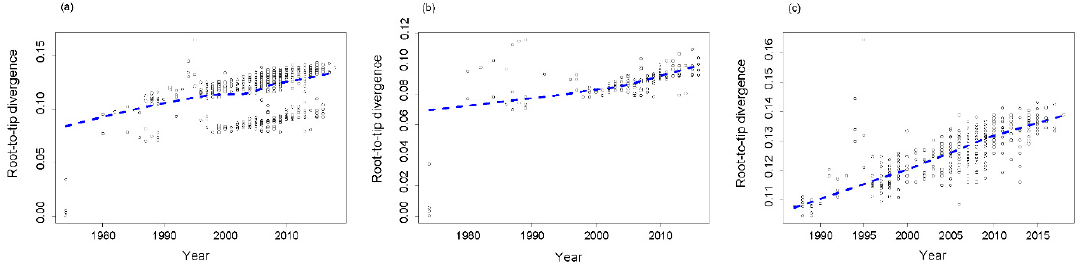
Figure 4. Root-to-tip divergence plots of the RVA G1 VP7 gene: ( a ) all analyzed strains, ( b ) lineage I, ( c ) lineage II. The Y -axis indicates the root-to-tip divergence based on the maximum likelihood tree, and the X -axis indicates the collection year. Each strain is represented by a circle, and the dashed line indicates a locally weighted scatterplot smoothing (LOWESS) line.